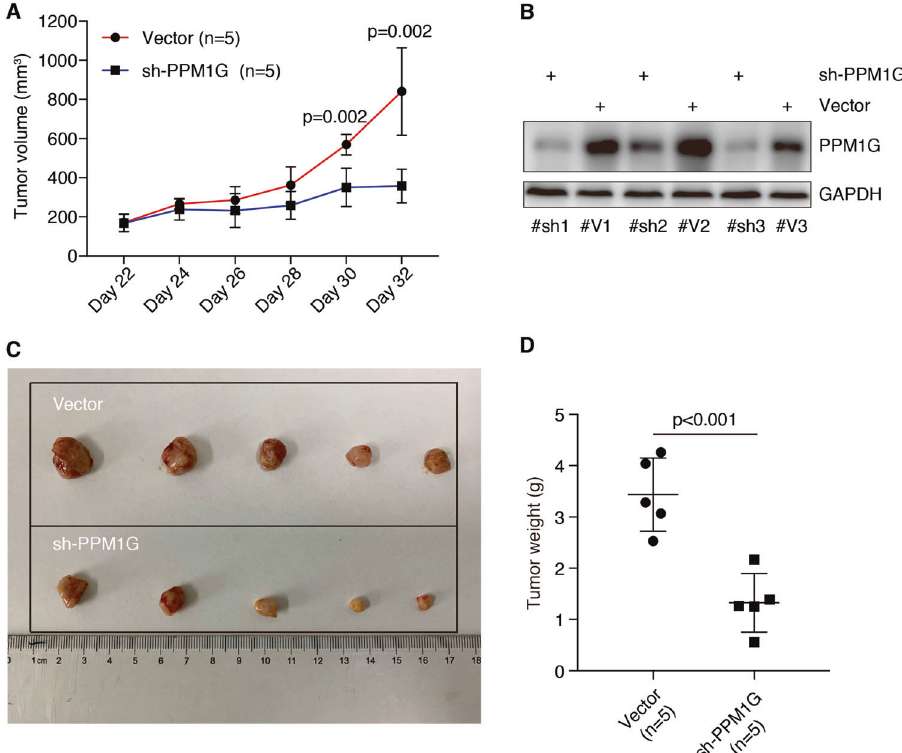
Fig. 4 Knockdown PPM1G inhibited tumor growth of HCC cells in vivo. A PPM1G is required for tumor growth of Hep3B cells in nude mice. Hep3B cells with PPM1G knockdown or transfected with vector were injected into the nude mice ( n = 5). Tumor sizes were examined after every two days after 22 days of transplantation. B Validate the expression of PPM1G in tumors. The expression of PPM1G in three pairs of transplanted tumors was examined. GAPDH was used as an internal control. C Decreased tumor size in HCC with PPM1G knockdown. Mice were sacri fi ced after 32 days of transplantation and the image of tumors was shown. D Decreased tumor weight in HCC with PPM1G knockdown. The tumor weight of each tumor was examined after 32 days of